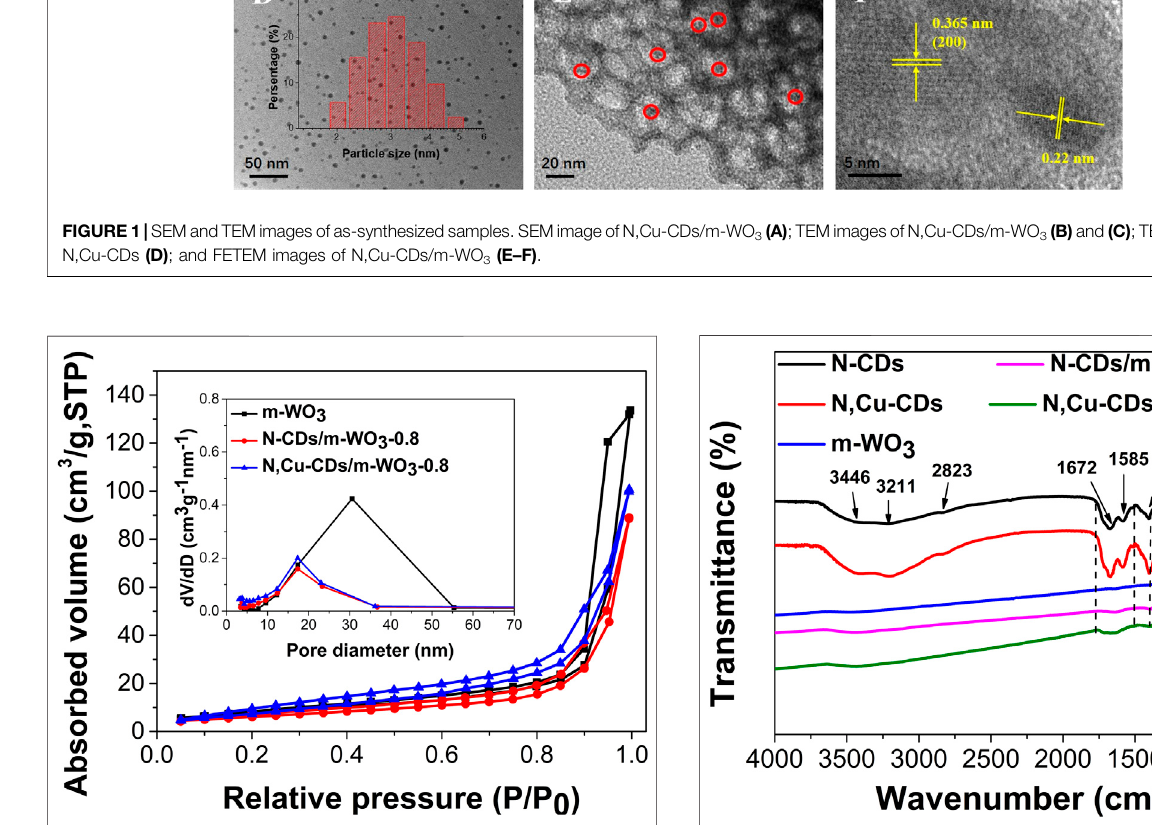
FIGURE 3 | FT-IR spectra of the as-synthesized